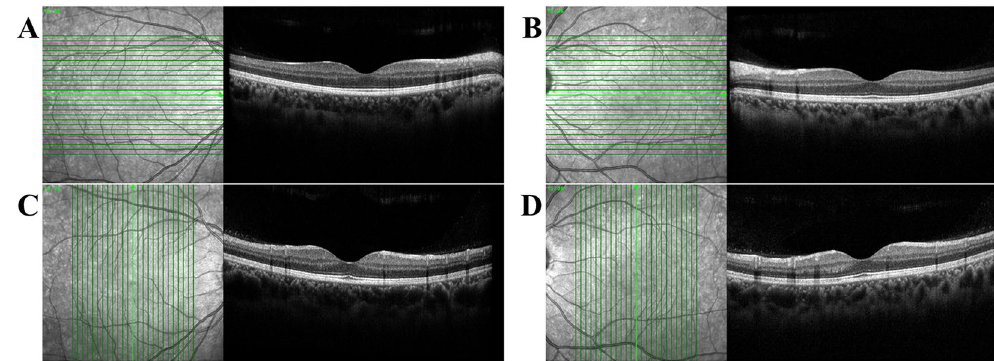
Figure 3. Optical coherence tomography (OCT) images used in the study. Twenty-five OCT images were obtained during one examination; only the median (13th) images were analyzed. A Right horizontal OCT image, B Left horizontal OCT image, C Right vertical OCT image, D Left vertical OCT image. In horizontal images ( A , B ), the optic disc is positioned on the right side of the right eye ( A ) and left side of the left eye ( B ). Since the retinal nerve fiber layer (RNFL) and major retinal vessels gather from the optic disc, the RNFL is thicker on the optic disc than on the opposite side. Also, shadows of the retinal vessels are easily identifiable on the optic disc side. As the optic discs of both eyes are located on the opposite sides, the horizontal images of the right and left eyes look like mirror images. In vertical images ( C , D ), the left side is the inferior part of the fovea (bottom of vertical green line), and the right side is the superior part of the fovea (top of vertical green line). Because the inferior and superior parts are located at similar distances from the optic disc, the RNFL thickness and the vascular shade density are similar. The vertical images of the right eye ( C ) and left eye ( D ) are difficult to